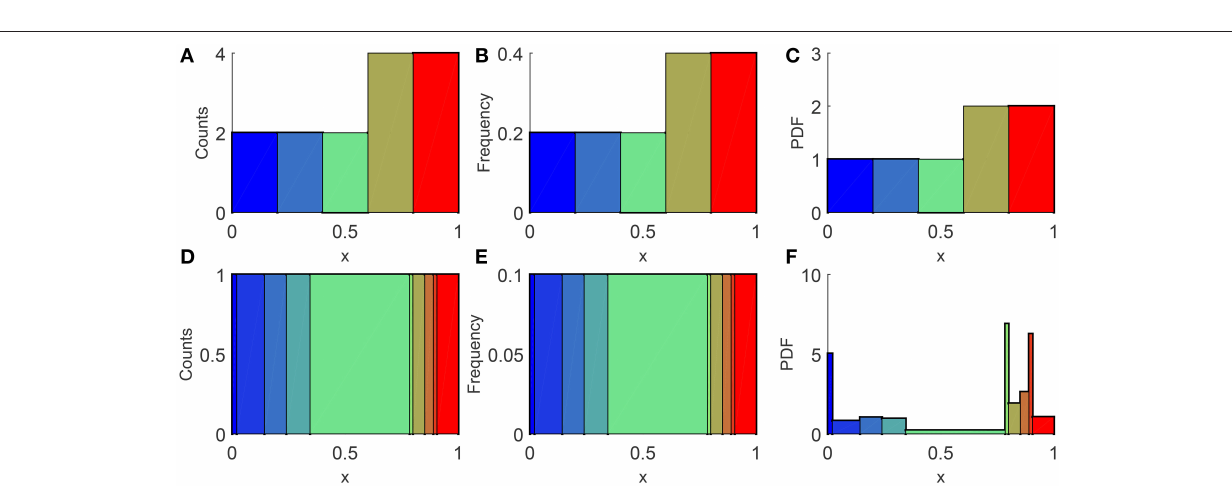
FIGURE 5 | Illustration of the distribution noise we would measure if we sample 10 elements from U (0,1), rescaled such that the largest element becomes 1. In (A,C) we use 5 uniform bins whereas in (D,F) we use the intervals between sorted elements as the bins. Counts are shown as (A,D) , and frequencies are shown as (B,E) . Whereas the probability densities calculated using Equation (17) are shown on the as (C,F)